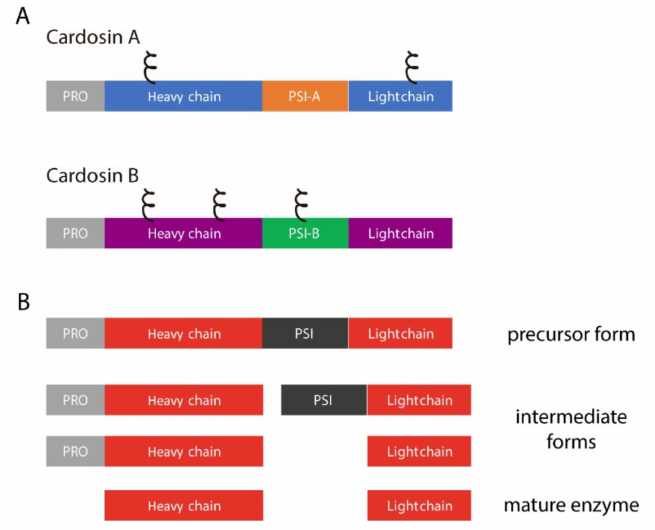
Figure 1. Cardosins’ organization and processing steps. ( A ) schematic representation of cardosins A and B, highlighting the di ff erent domains and predicted glycosylation sites ( ξ ); PSI–Plant Specific Domain; PRO–prosegment; ( B ) Sequential processing steps usually taken by aspartic proteinases